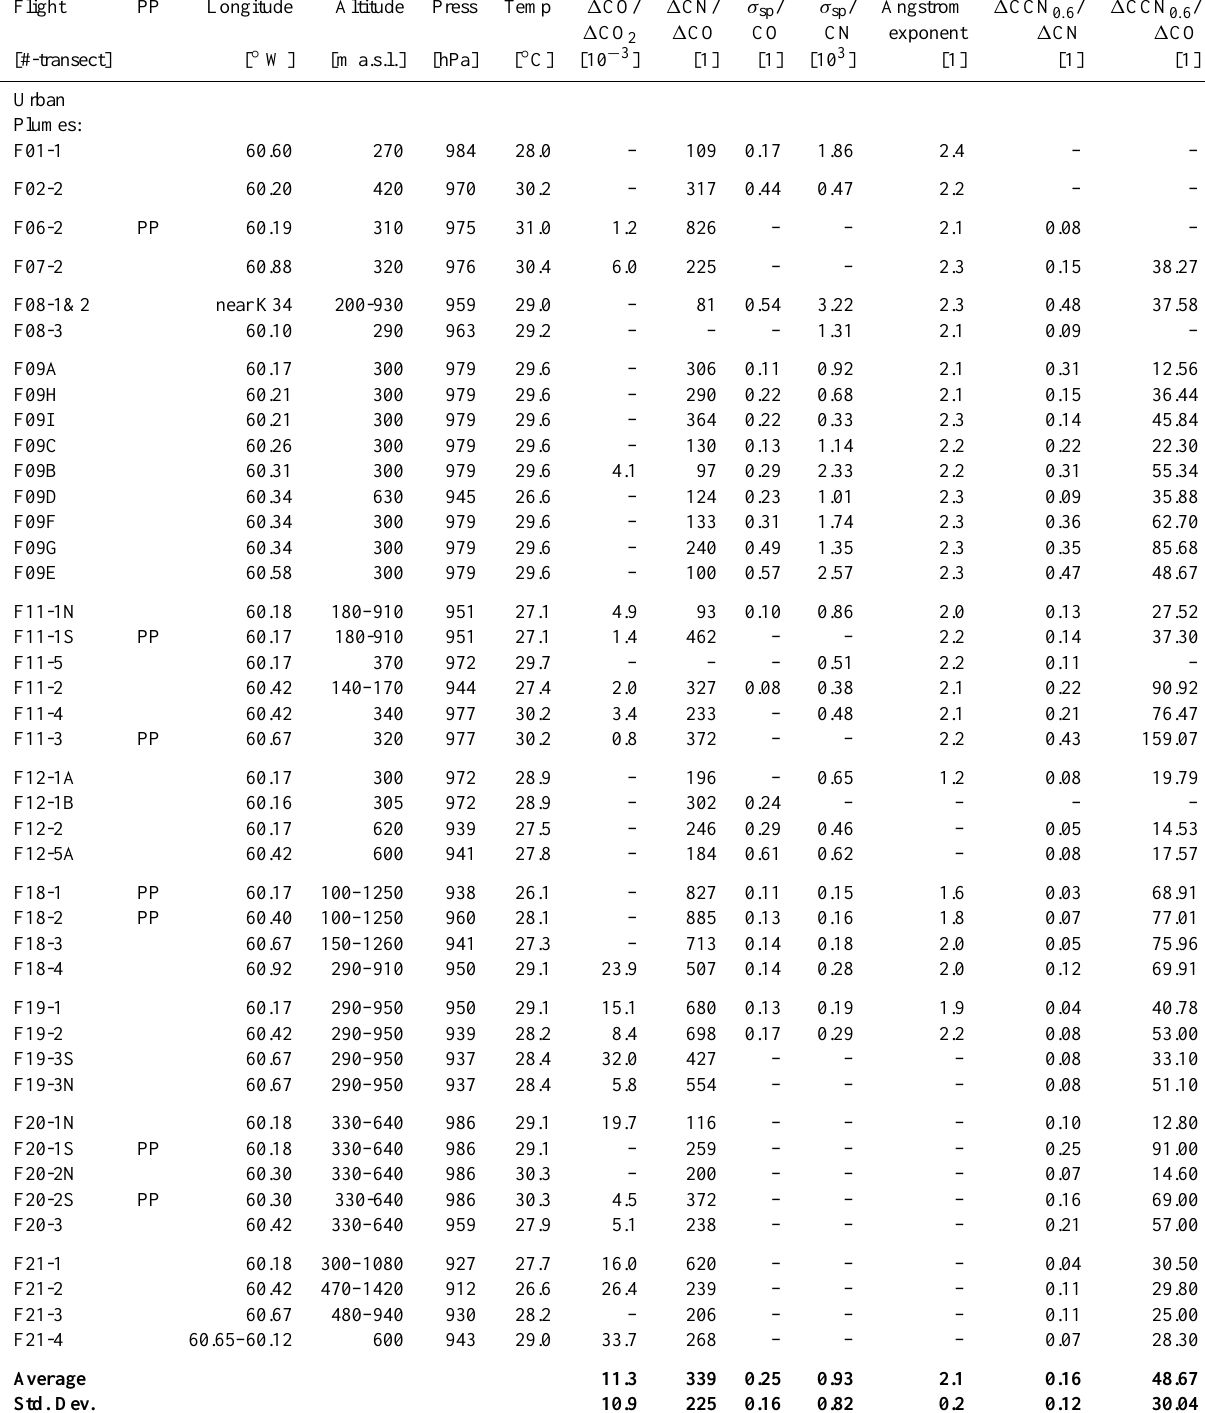
Table 2. Overview of all the plume encounters made during the LBA-CLAIRE-2001 flights (Manaus plumes in the upper part, and biomass burning plumes in the lower part). PP means that power plant plume was sampled, based on trajectory analysis. σ sp (550nm) is the scattering coefficient at 550nm wavelength. All concentrations and scattering coefficients have been normalized to standard conditions in dry air (273.15K,